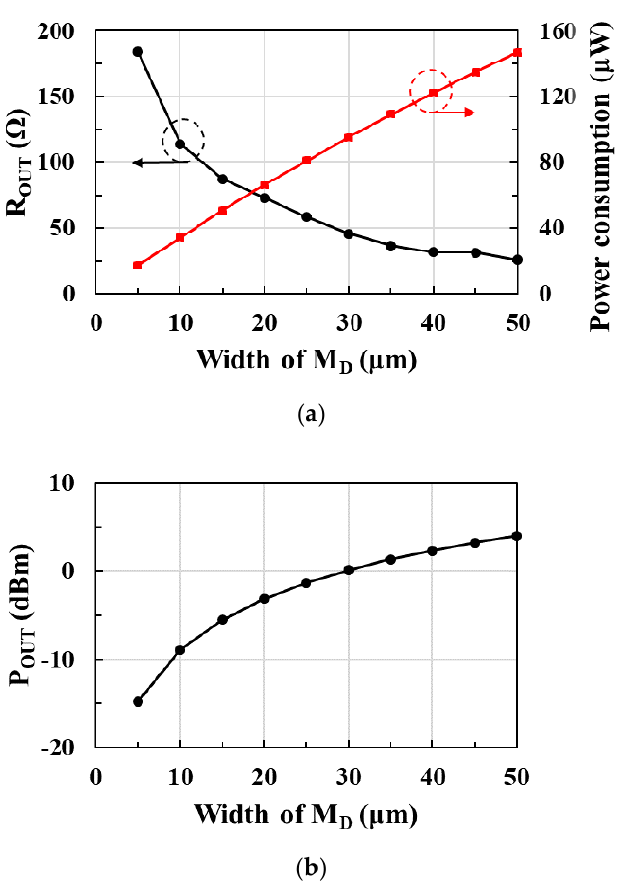
Figure 9. ( a ) Output resistance (R OUT ), power consumption, and ( b ) output power (P OUT ) of the drive amplifier according to the width of M D .